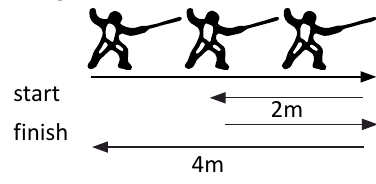
Figure 1. 4-2-2-4-m shuttle test 7-m Repeat Lunge Ability Test (7-m RLA): During the test, all the fencers’ backward and forward moves were performed in the en-garde position. With the help of electronic photocells (Fusion Sport, Smart Speed Pro, Australia), as in the previous test, the system was automatically activated when the fencers passed through the photocells. The test started by going 7-m forward in the en-garde position and performing the specific lunge movement for fencing at the finish line. Afterwards, the fencers came back 4-m and then moved 4-m forward again, performing the lunge at the finish line. Fencers repeated this move until they made a total of five lunges. After making the fifth lunge to the target area, the fencers stepped back 7-m to the starting line [19]. The test illustrated in figure